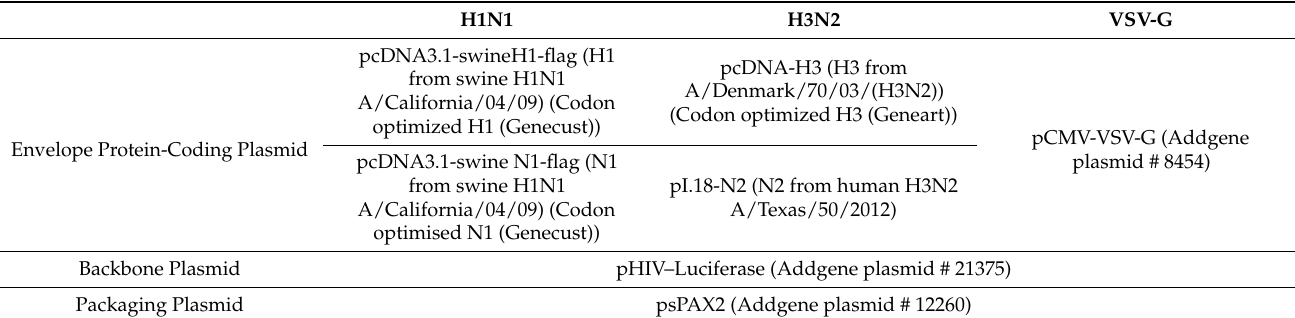
Table 3. Plasmids used for pseudo-typed lentivirus particle production